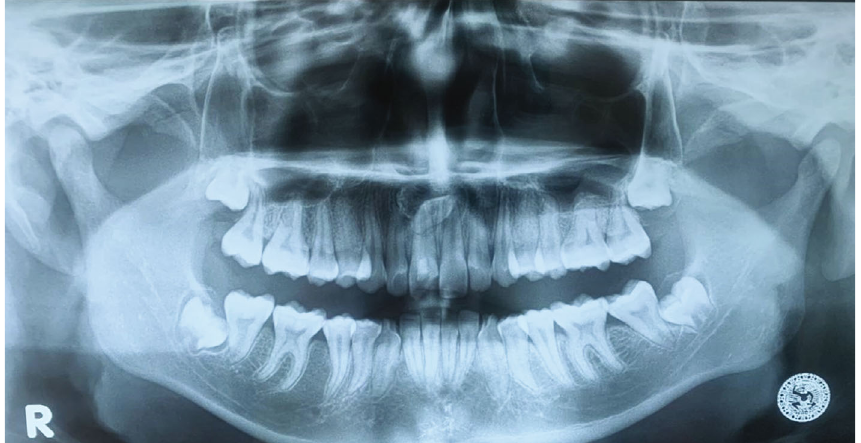
Figure 4: Panoramic radiographic view. Panoramic radiograph revealing a well-de fi ned unilocular radiolucency around impacted mesiodens.